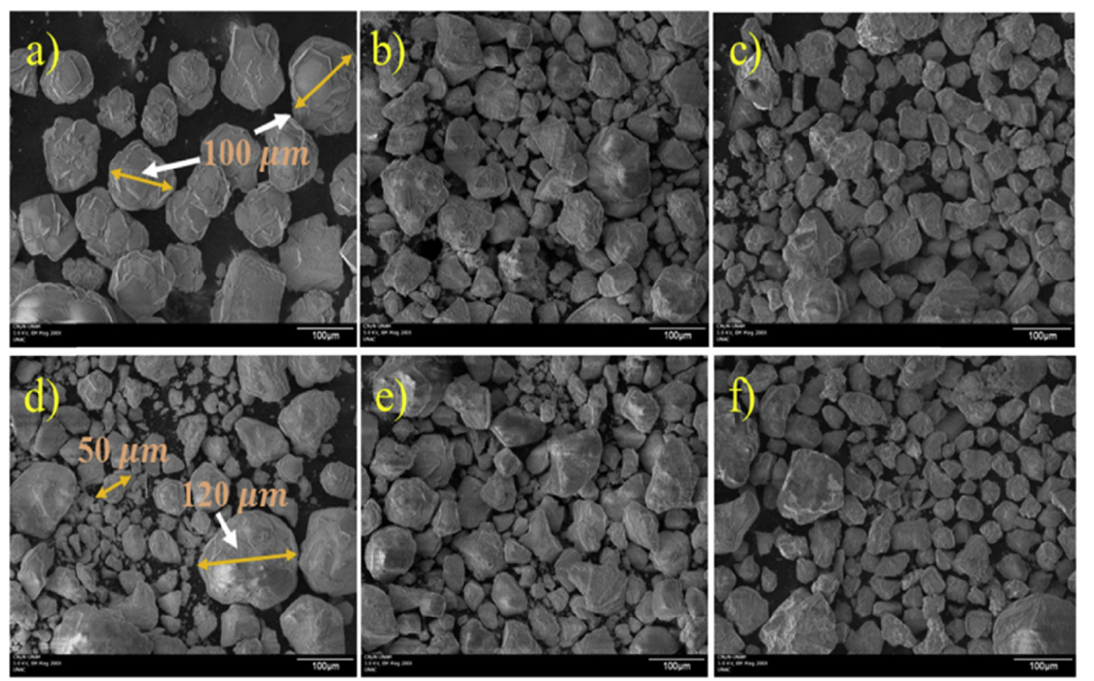
Figure 5. ( a ) γ -Al 2 O 3 as received, ( b ) fresh Fe 2 O 3 - γ Al2O3 catalyst, ( c ) fresh CuO/ γ -Al 2 O 3 catalyst, ( d ) fresh CuO-Fe 2 O 3 / γ -Al 2 O 3 catalyst, ( e ) CuO-Fe 2 O 3 / γ -Al 2 O 3 after reaction at 250 ° C, and ( f ) CuO- Fe 2 O 3 / γ -Al 2 O 3 after reaction at 290 ° C. Reproduced with copyright permission from [81]